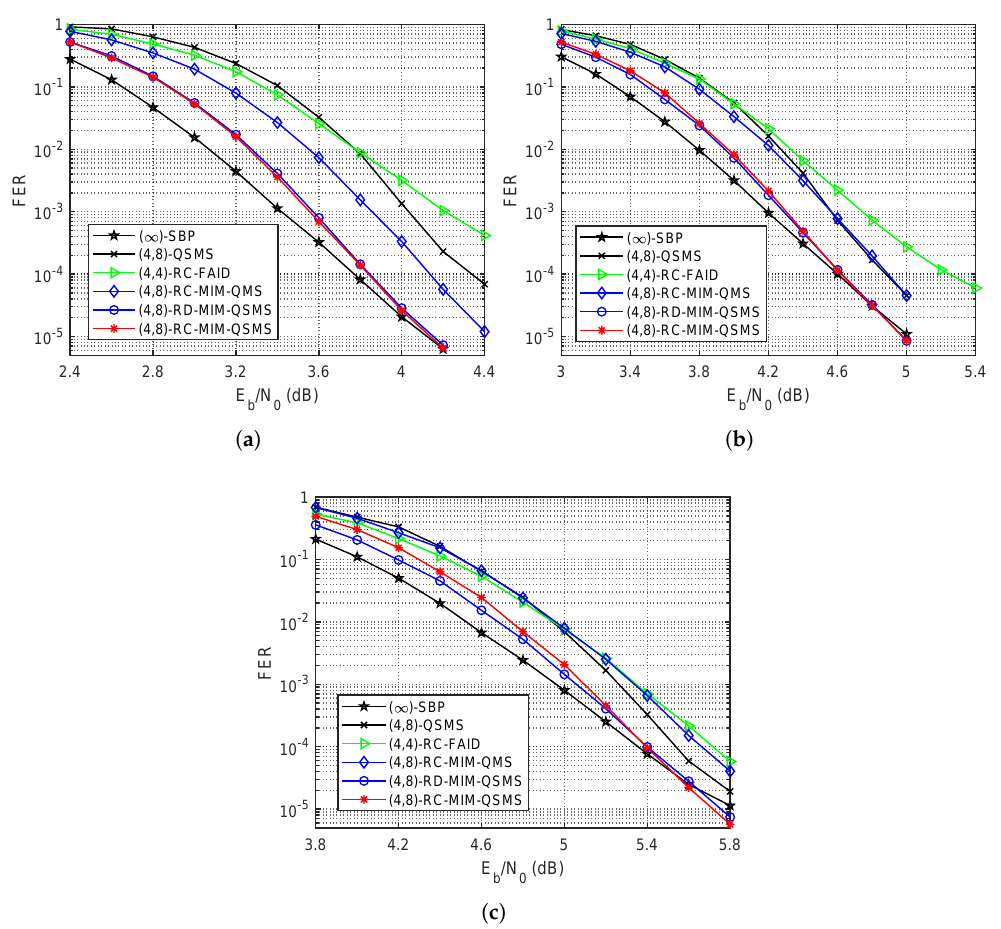
Figure 3. The FER performance of different decoders for the 5G LDPC codes with lifting size 26 and code rates 3/4, 5/6, and 8/9. ( a ) R c = 3/4. ( b ) R c = 5/6. ( c ) R c =